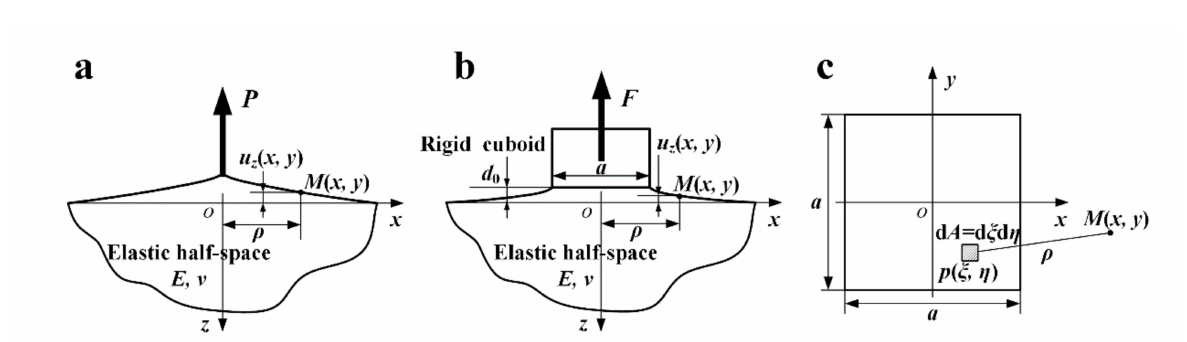
Figure 2. Schematics of ( a ) concentrated normal force P applied to an elastic half-space; ( b ) rigid cuboid adhered to an elastic half-space under normal loading F ; ( c ) area element d A of integration area. u z ( x , y ): vertical displacement of point M ; ρ : the horizontal distance from P or F to M ; d 0 : vertical displacement of the rigid cuboid. p ( x , y ) or p ( ξ , η ): distribution pressure at the contact area caused by F